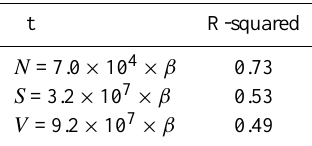
Table 2. Linear relations linking the backscatter coefficient to par- ticle number, surface and volume density. Here β is expressed in m − 1 sr − 1 , while N , S , and V are expressed respectively in cm − 3